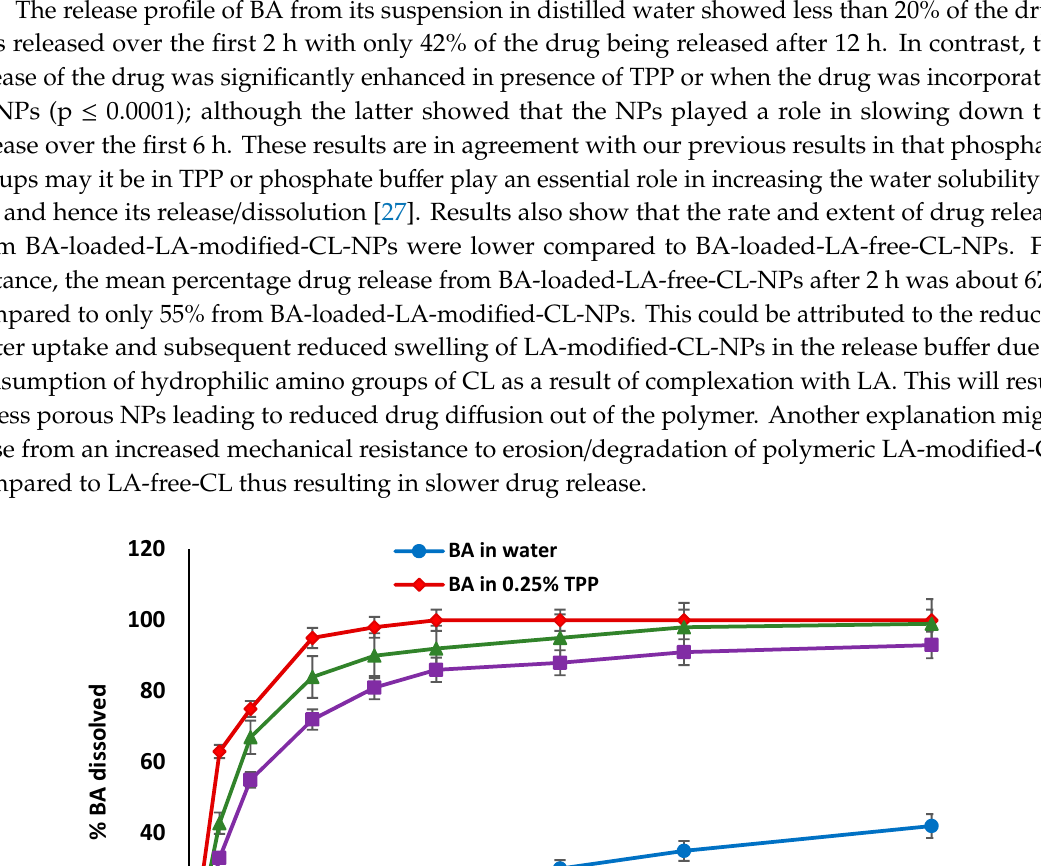
Figure 3. ATR spectra of ( a ) LA; ( b ) CL; ( c ) BA-loaded-LA-modified-CL-NPs; ( d ) BA-loaded-LA-free- CL-NPs and ( e ) BA. The closed stars represent the amine characteristic bands of CL, the open stars represent the absence of the amine characteristic bands of CL and the dots represent the aromatic characteristic bands attributed to the drug.